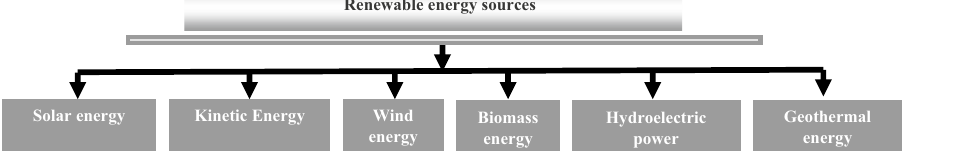
Figure 2. Renewable energy